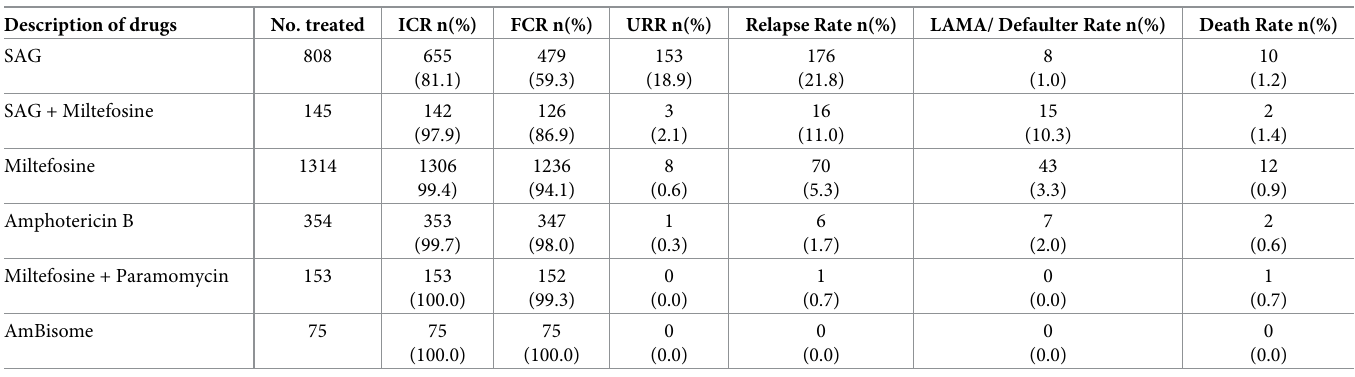
Table 4. Response of drugs administered for the treatment (N =